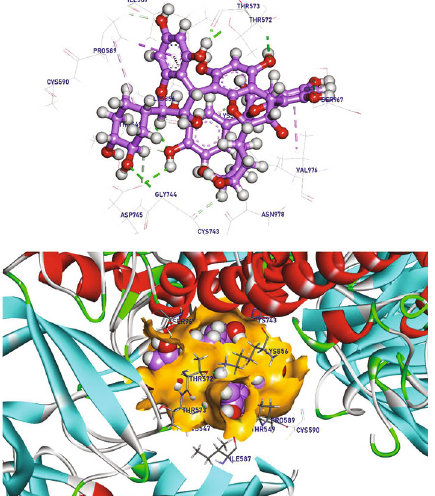
Figure 12: Proanthocyanidin-C1 docked in RBD-SARS-CoV-2 Omicron spike protein, hydrogen bonds (green), and the pi interactions are represented in purple